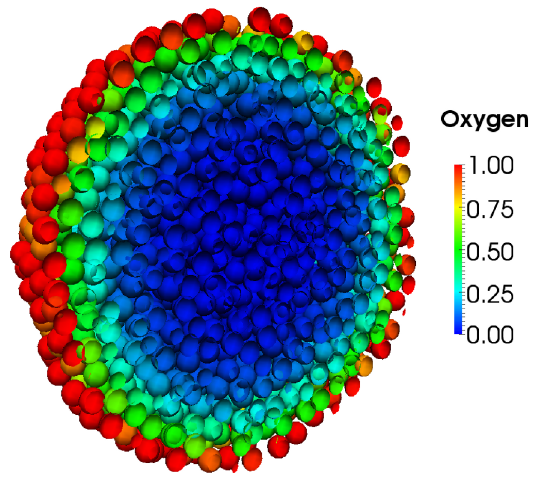
Figure 1. 3D off-lattice simulation coupled to PDE: 3D simulation of a tumour spheroid. A cross-section of a tumour spheroid is presented. Cell centres, nodes of a mesh, are represented by spherical shells and coloured according to the local oxygen concentra- tion. Proliferation is dependent on oxygen, which diffuses and is taken up by cells in the spheroid, such that only cells near the outer rim divide. Cell death occurs under low oxygen conditions near the centre of the spheroid. See also Video